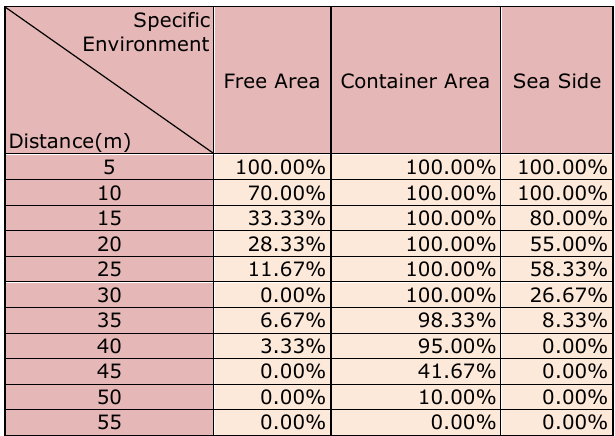
Table 3. Results of distance